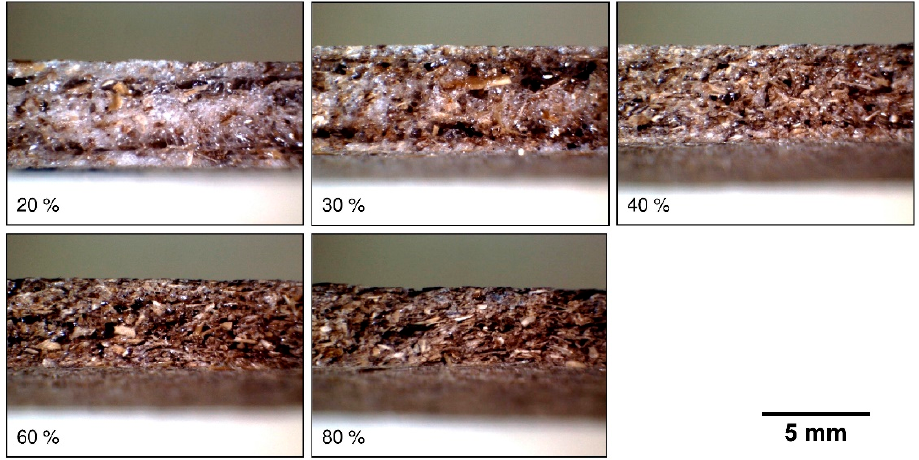
Figure 7. Macrographs (8× magnification) for cross-sections of the trays with different BSG contents (20%, 30%, 40%, 60% and 80%).